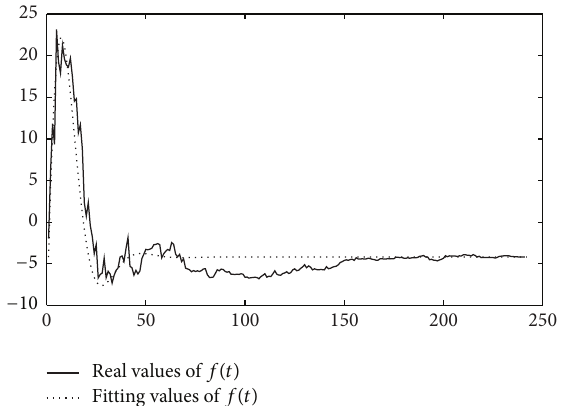
Real values of Fitting values of f(t) Figure4:Realvaluesversusfittingvaluesof 𝑓(𝑡) duringAsiancrisis.